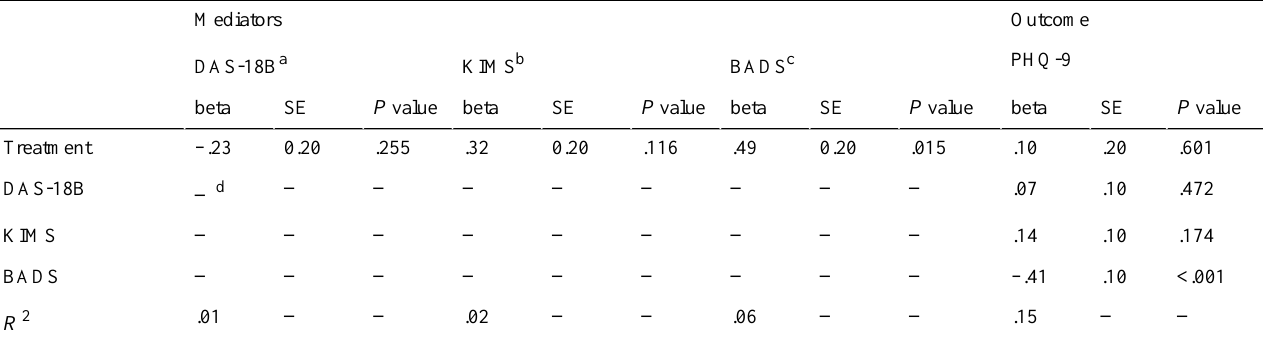
Table 6. Mediation analysis: Effects of treatment (internet-based behavioral activation, coded as 1, vs the pooled control groups, coded as 0) on the mediators and the effects of the mediators (including treatment) on depression, as measured by the Patient Health Questionnaire-9 (PHQ-9). OutcomeMediators